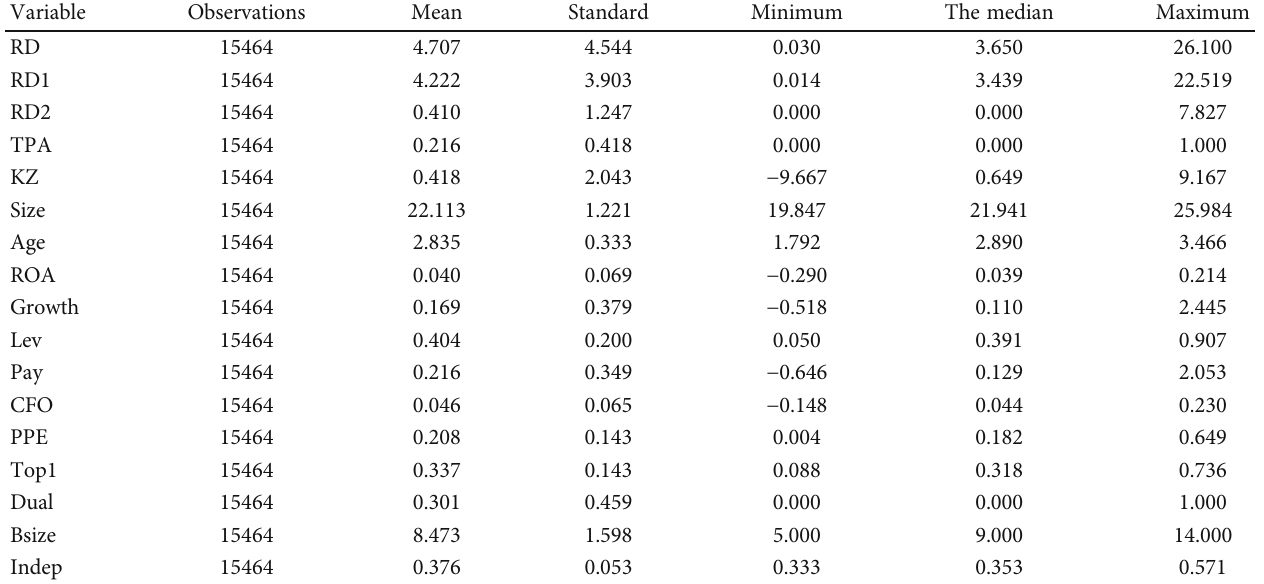
Table 2: Descriptive statistical